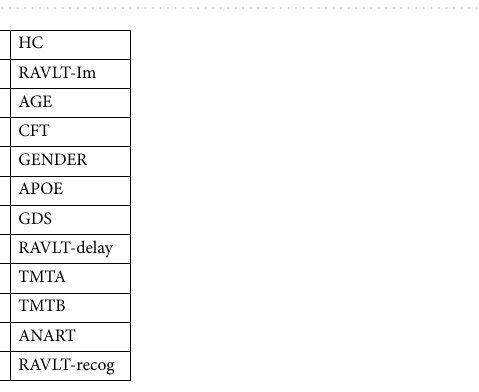
Table 3. The table depicts each feature’s importance in descending order calculated by permutation. The leftmost column in each row depict average effect on model accuracy by random shuffling ± how the accuracy varied from one reshuffling to the next. The two most important features are hippocampal volume and RAVLT immediate, followed by age, category fluency and gender.